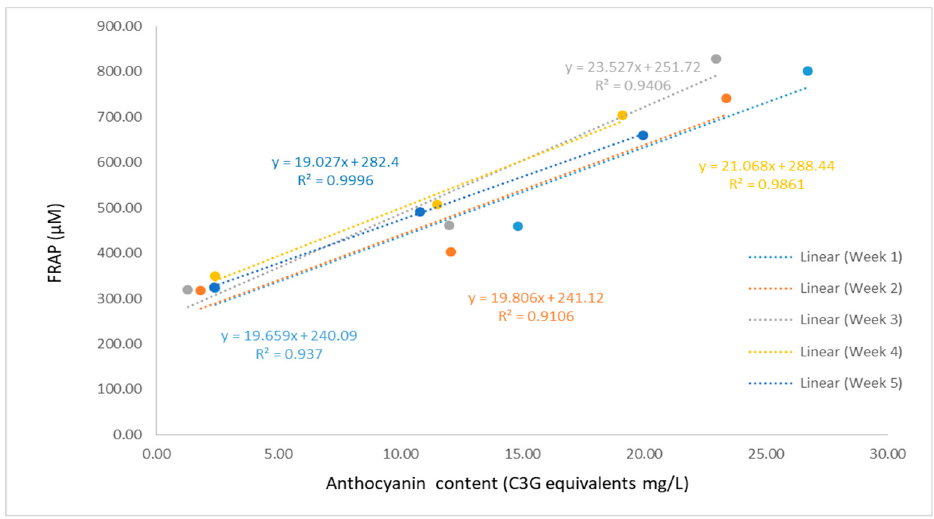
Figure 6. FRAP (ferric reducing antioxidant power) assay of different yogurt beverages. Results are presented as means ± SD. Different low case letters denote significant differences at each time point ( p < 0.05).